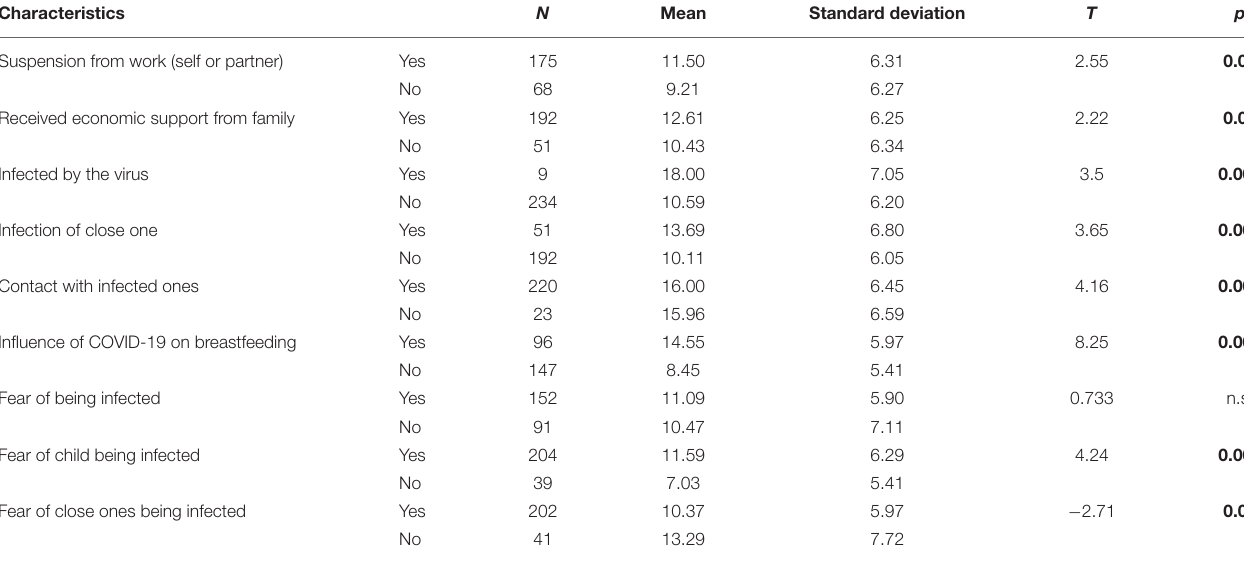
TABLE 3 | Effects of COVID-19 related variables on Edinburgh Postnatal Depression Scale (EPDS) total score.